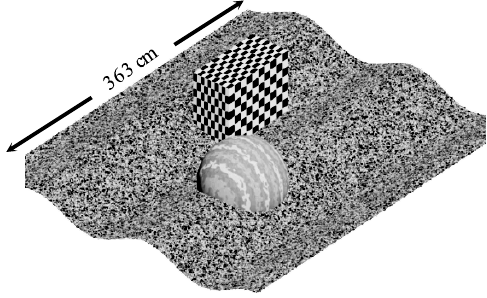
Figure 1: Computer-generated 3D primitives dataset.